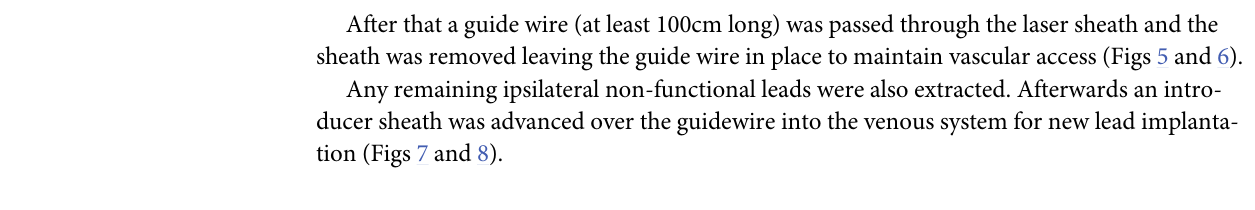
PLOS ONE | https://doi.org/10.1371/journal.pone.0251829 May 14,